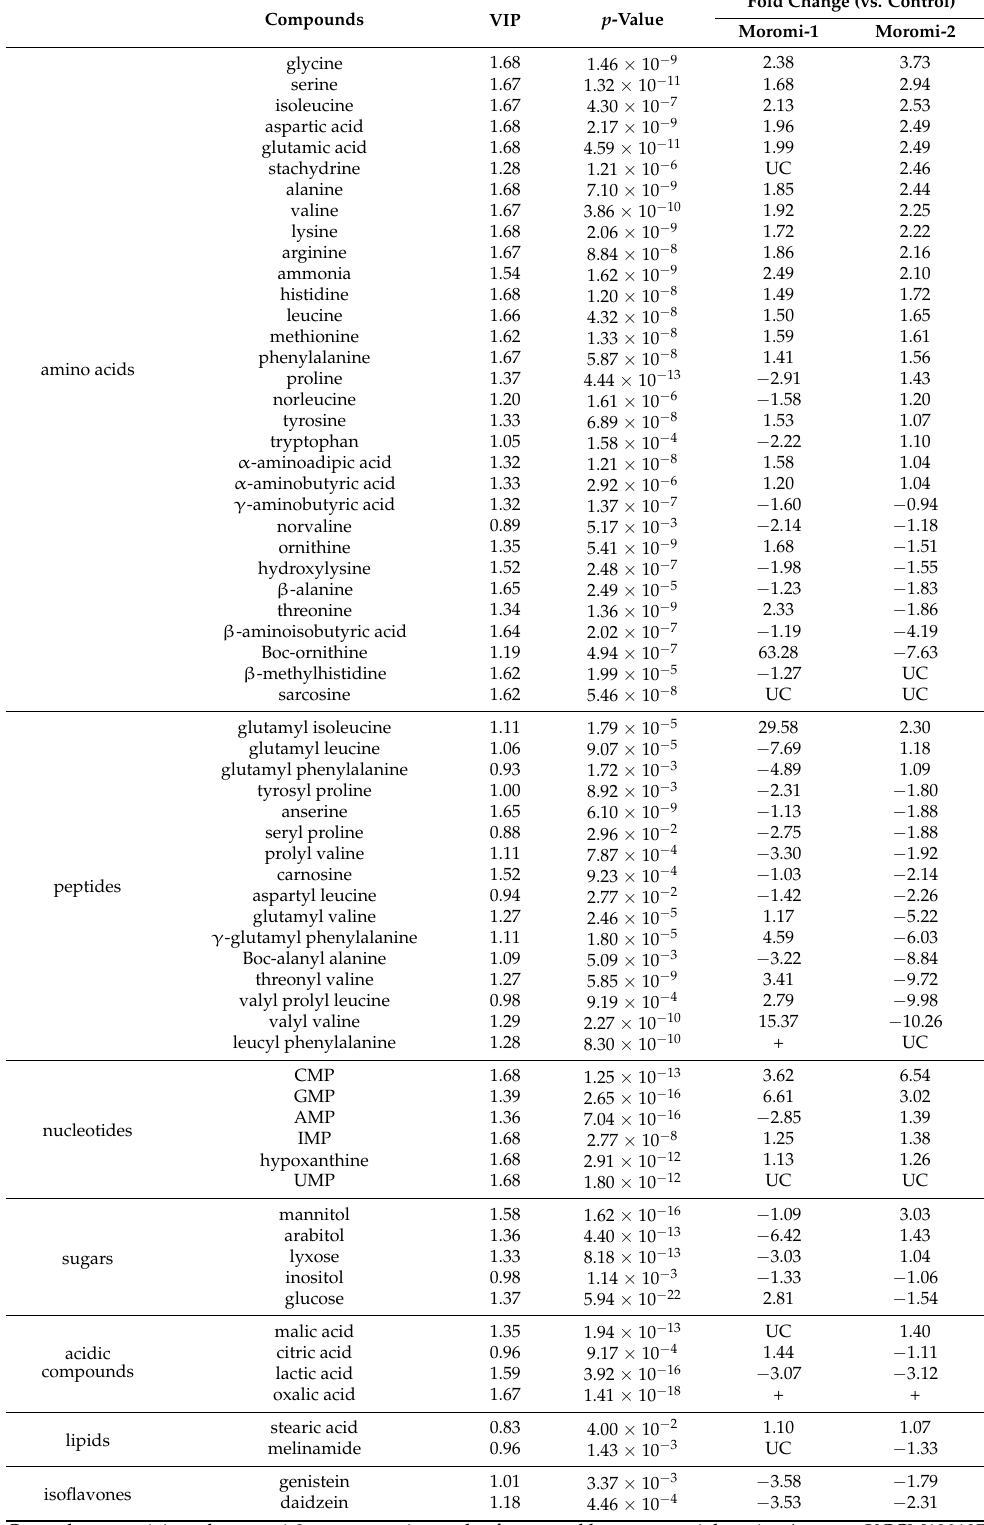
Table 2. Identification of major metabolites contributing to the separation of samples on the PLS-DA score plots and their fold